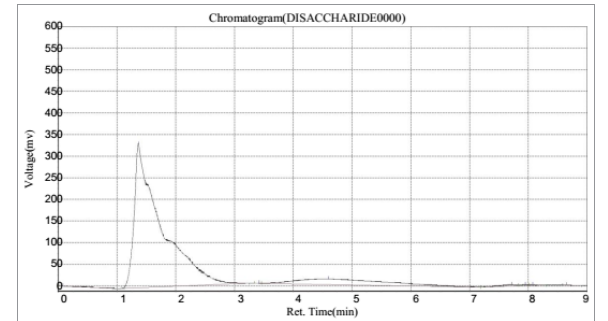
High-performance liquid chromatogram of yellow variety of tiger nut